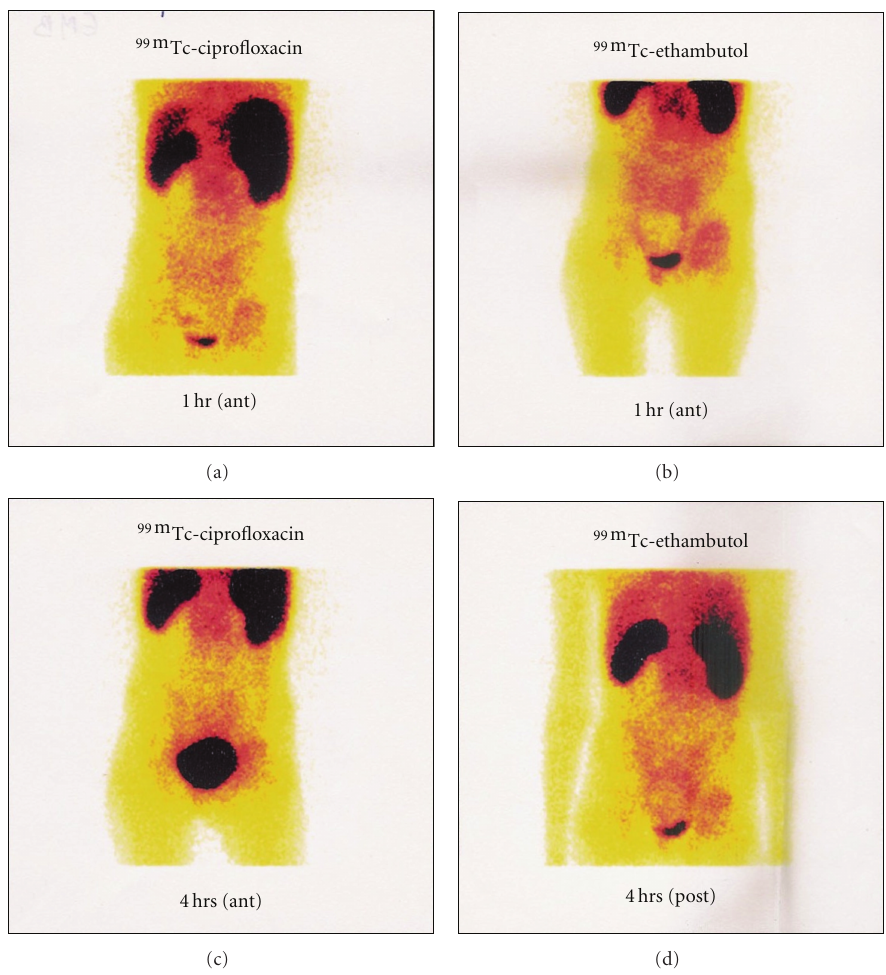
Figure 6: Scintigram showing comparative study of preferential localization of 99m Tc-Ciprofloxacin and 99m Tc-EMB in a patient after 1 hour (Figures 1 and 2, resp.) and 4 hours (Figures 3 and 4, resp.) postinjection of 370 MBq of 99m Tc-Ciprofloxacin and 99m Tc-EMB,